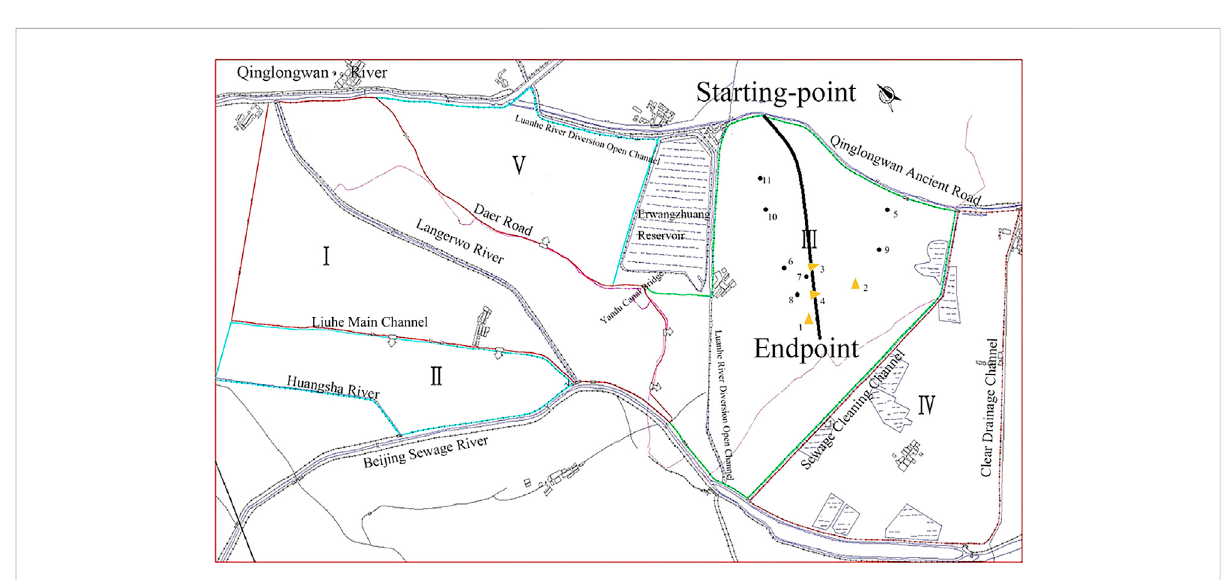
FIGURE 1 Partition map of the Da Huang Pu fl ood storage and detention area. To illustrate the locations of 11 observation points, we use Photoshop for image processing. The DaHuangPu fl ood storage and detention area is divided into Ⅰ , Ⅱ , Ⅲ , Ⅳ , and Ⅴ by the dikes of the Liuhe Main Channel,